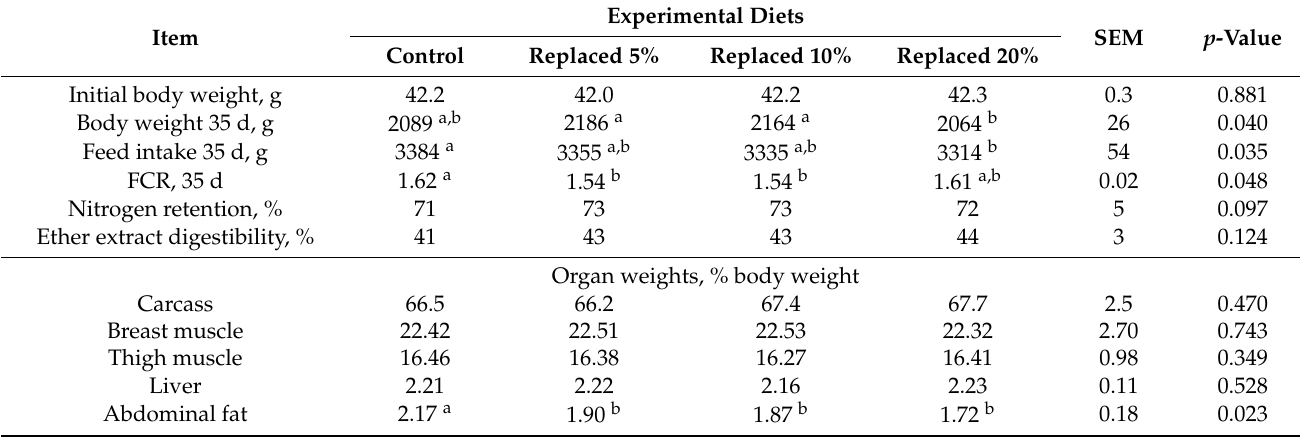
Table 3. The effects of replacing corn with olive cake meal (OCM) on broilers’ growth performance and organ weights.